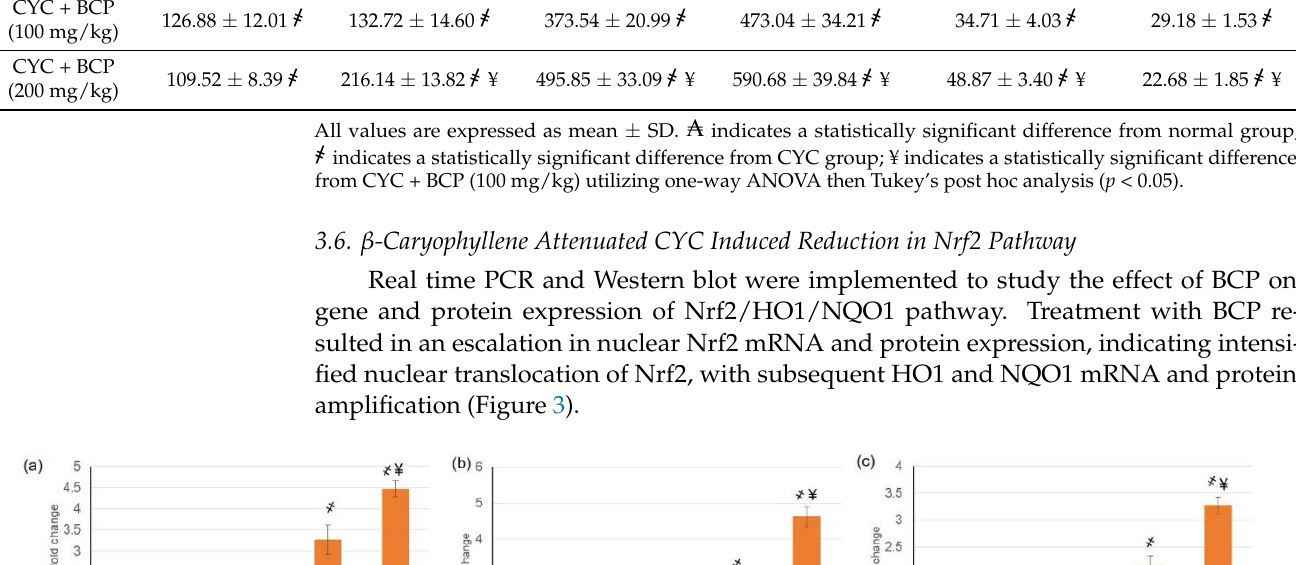
Table 2. Effects of treatment with β -caryophyllene (BCP) for 14 days on cyclophosphamide (CYC) induced fluctuations in ECG and heart rate.